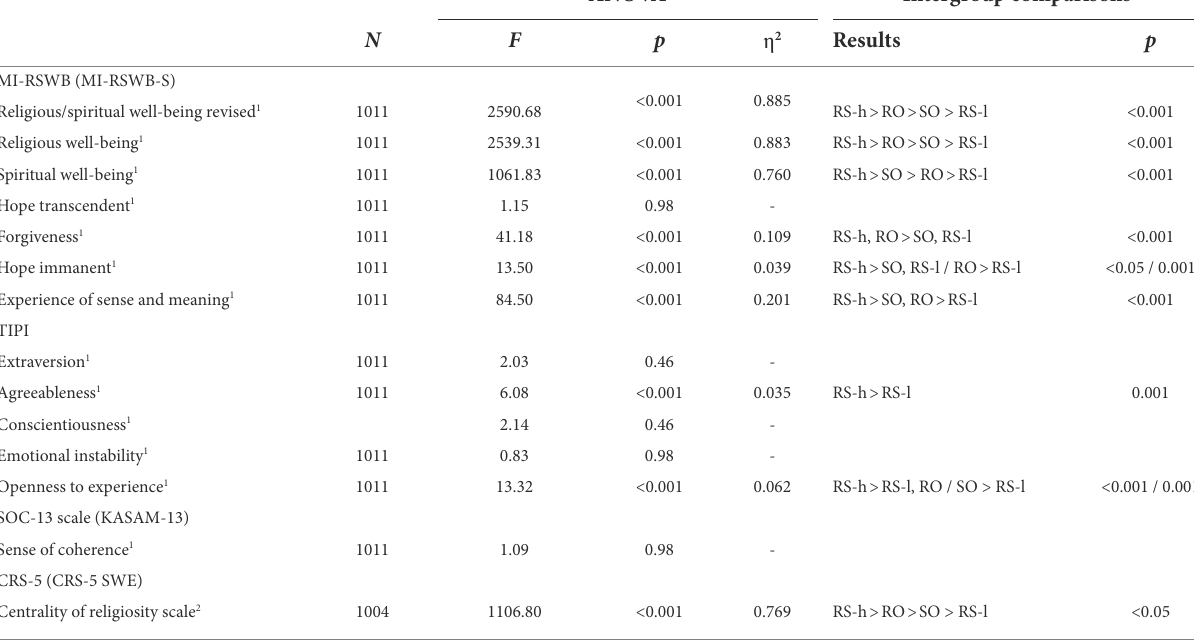
TABLE 4 ANOVAs and intergroup comparisons for the MI-RSWB (subscales and joint factor), TIPI, SOC-13 scale, and CRS-5.